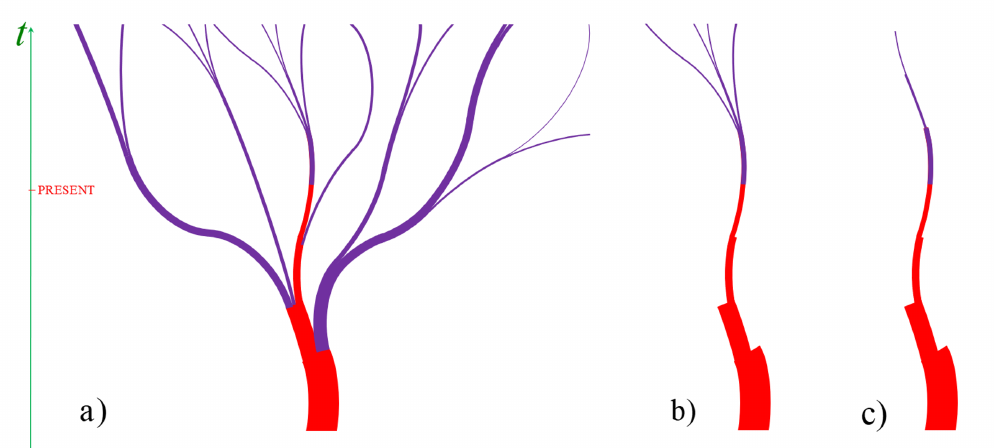
Figure 3. The world structure in the MWI and a single-world universe. ( a ) The whole tree of many worlds in the MWI. ( b ) One world of the MWI until present together with the tree of future worlds splitting out of it in the future. ( c ) One of the corresponding worlds of the theory with